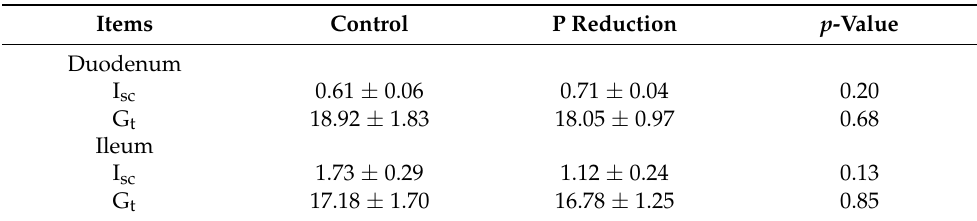
Table 5. Electrophysiological properties of duodenal and ileal epithelia of young goats fed a low phosphorus (P) diet. (Mean values with their standard errors; n = 7 animals). Items